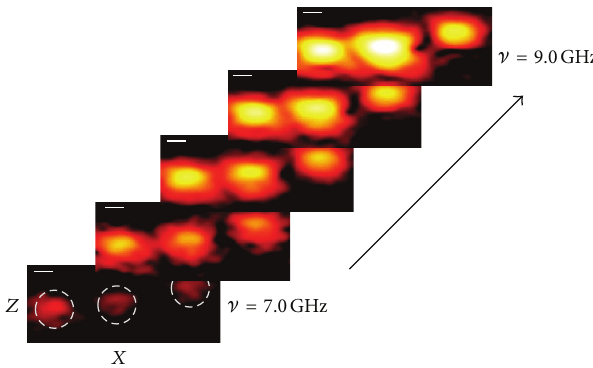
Figure 3: Spectroscopic TA cross-sectional images of semiconduct- ing SWNTs (left tube), metallic SWNTs (middle tube), and deion- izedwater(righttube),acquiredwithexcitationfrequenciesbetween 7 and 9GHz ( Δ ] = 0.5 GHz). Tube walls are outlined by gray circles in bottom image. A strong spectral dependence is observed for each sample. Dynamic range is 30 dB for all, scale bar = 2